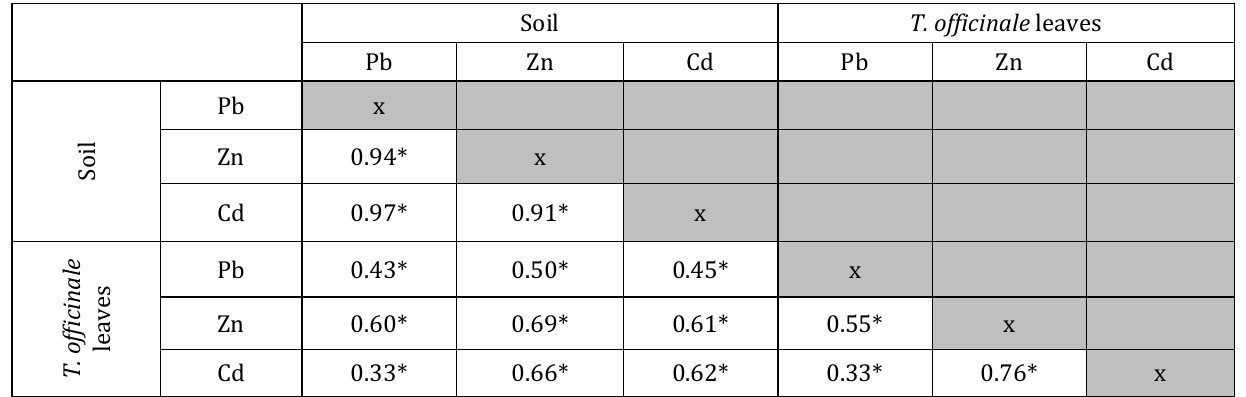
Table 2. Correlation coefficients (k) of heavy metals concentration in soil and leaves of T. officinale *the level of significance